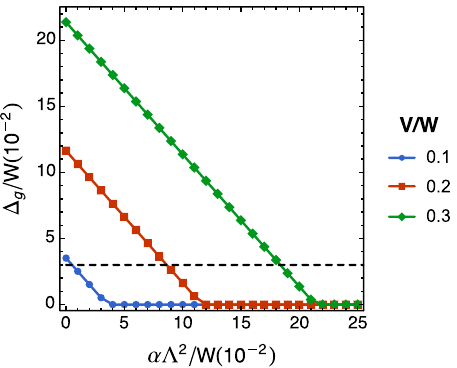
Fig. 8 Mean- fi eld insulating gap. The plot shows the insulating gap at half- fi lling as a function of parameter α for various interaction strength. The dotted line is the observed insulating gap in the experiment (assuming the bandwidth is ~ 100 meV).